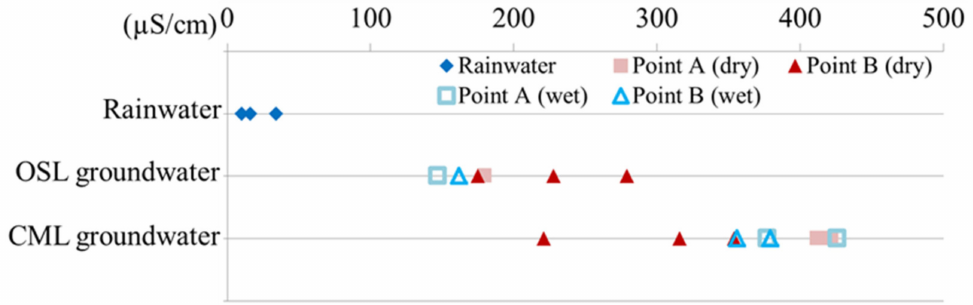
Figure 8. EC of collected water